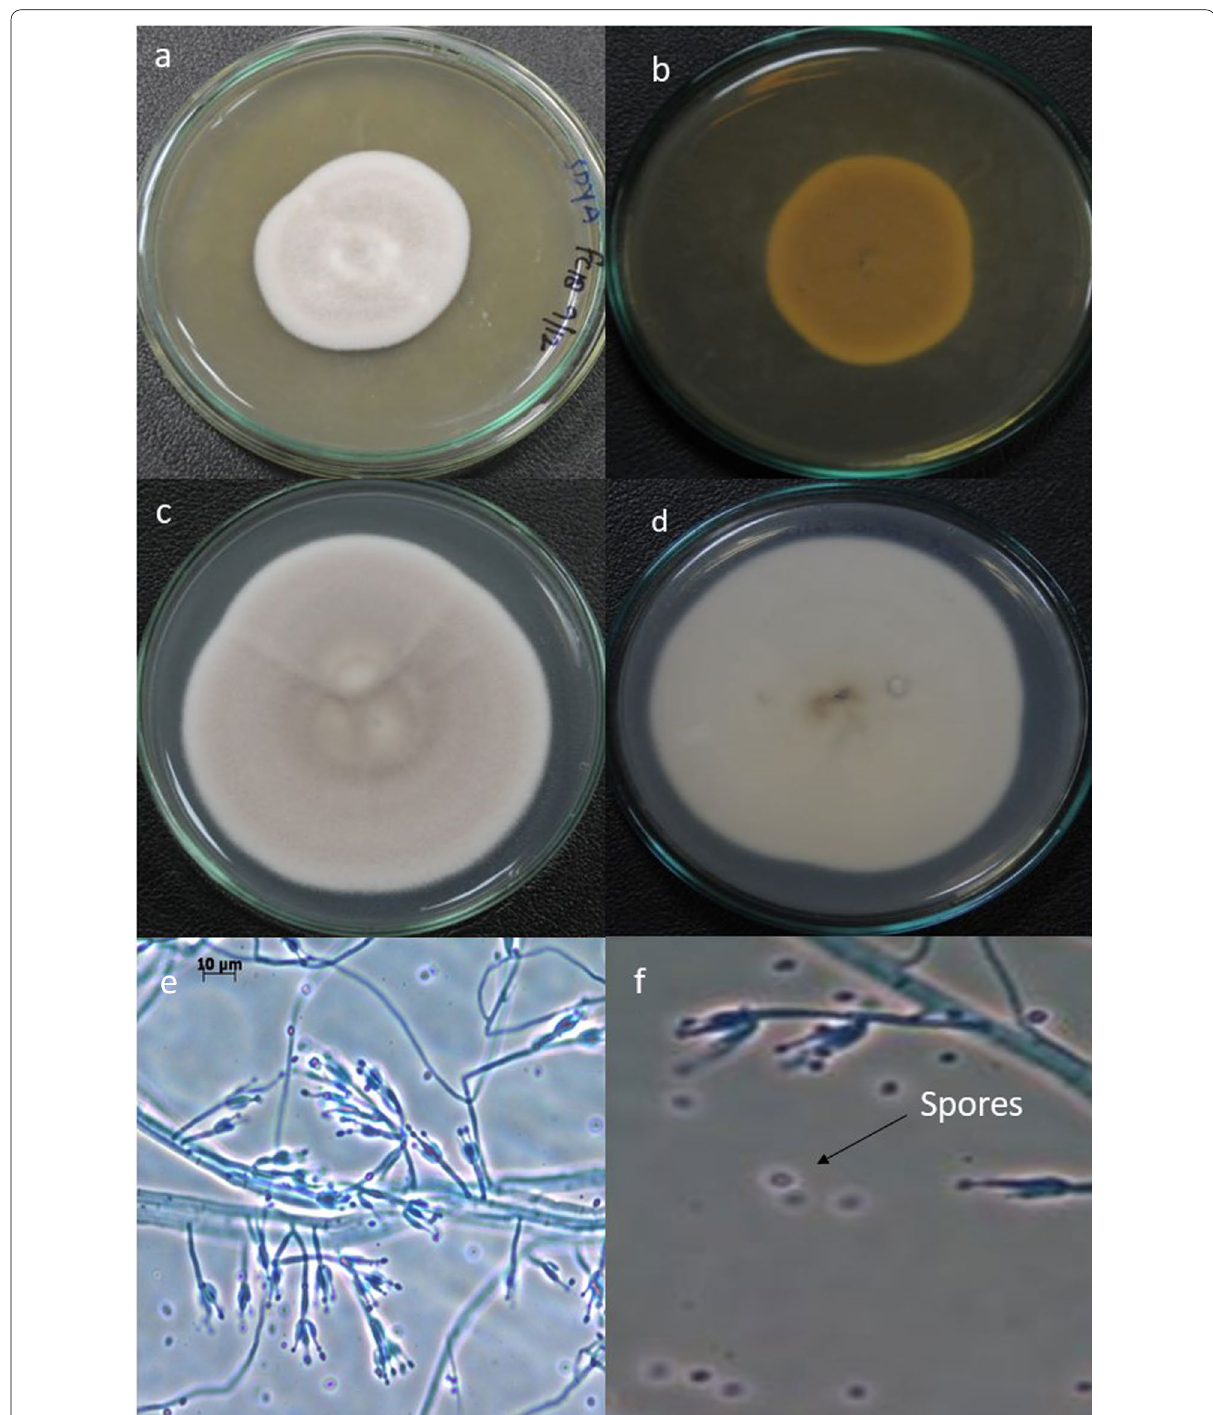
Fig. 2 Colony growth of Purpureocillium lilacinum on different culture media after 14 days of incubation at 25 °C a Frontal view of P. lilacinum on SDYA medium, b Rear view of P. lilacinum on SDYA medium, c Frontal view of P. lilacinum on MEA medium, d Rear view of P. lilacinum on SDYA medium, e , f Microscopic pictures showing phenotypic characteristics, viz. conidiophores arising from mycelial hyphae, phialides, phialospores (conidia) of P.